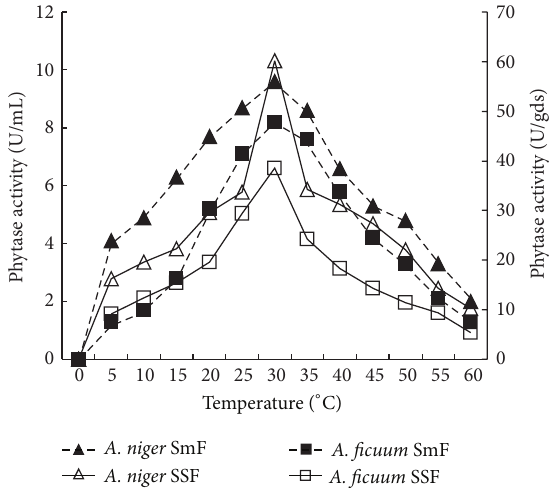
Figure 4: Effect of temperature on phytase production by Asper- gillus niger CFR 335 and Aspergillus ficuum SGA 01 in submerged and solid-state fermentation.